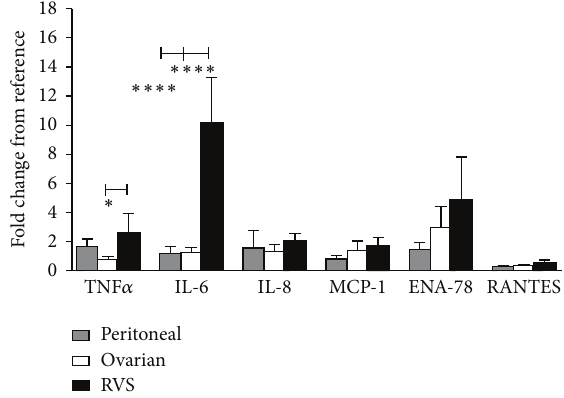
Figure 3: Comparison of cytokine and chemokine concentrations in endometriotic lesions from different locations. A comparison of the mRNA expression between endometriotic lesions from different locations indicated that TNF 𝛼 expression in the RVS was significantly higher than expression in the ovarian lesions. IL-6 mRNAexpressionwassignificantlyhigherintheRVSthaneitherthe ovarian or the peritoneal lesions. There was no significant difference between the lesions with any of the other cytokines. All values are represented by mean ± SEM. ∗ < .05 , ∗∗∗∗ < .0001